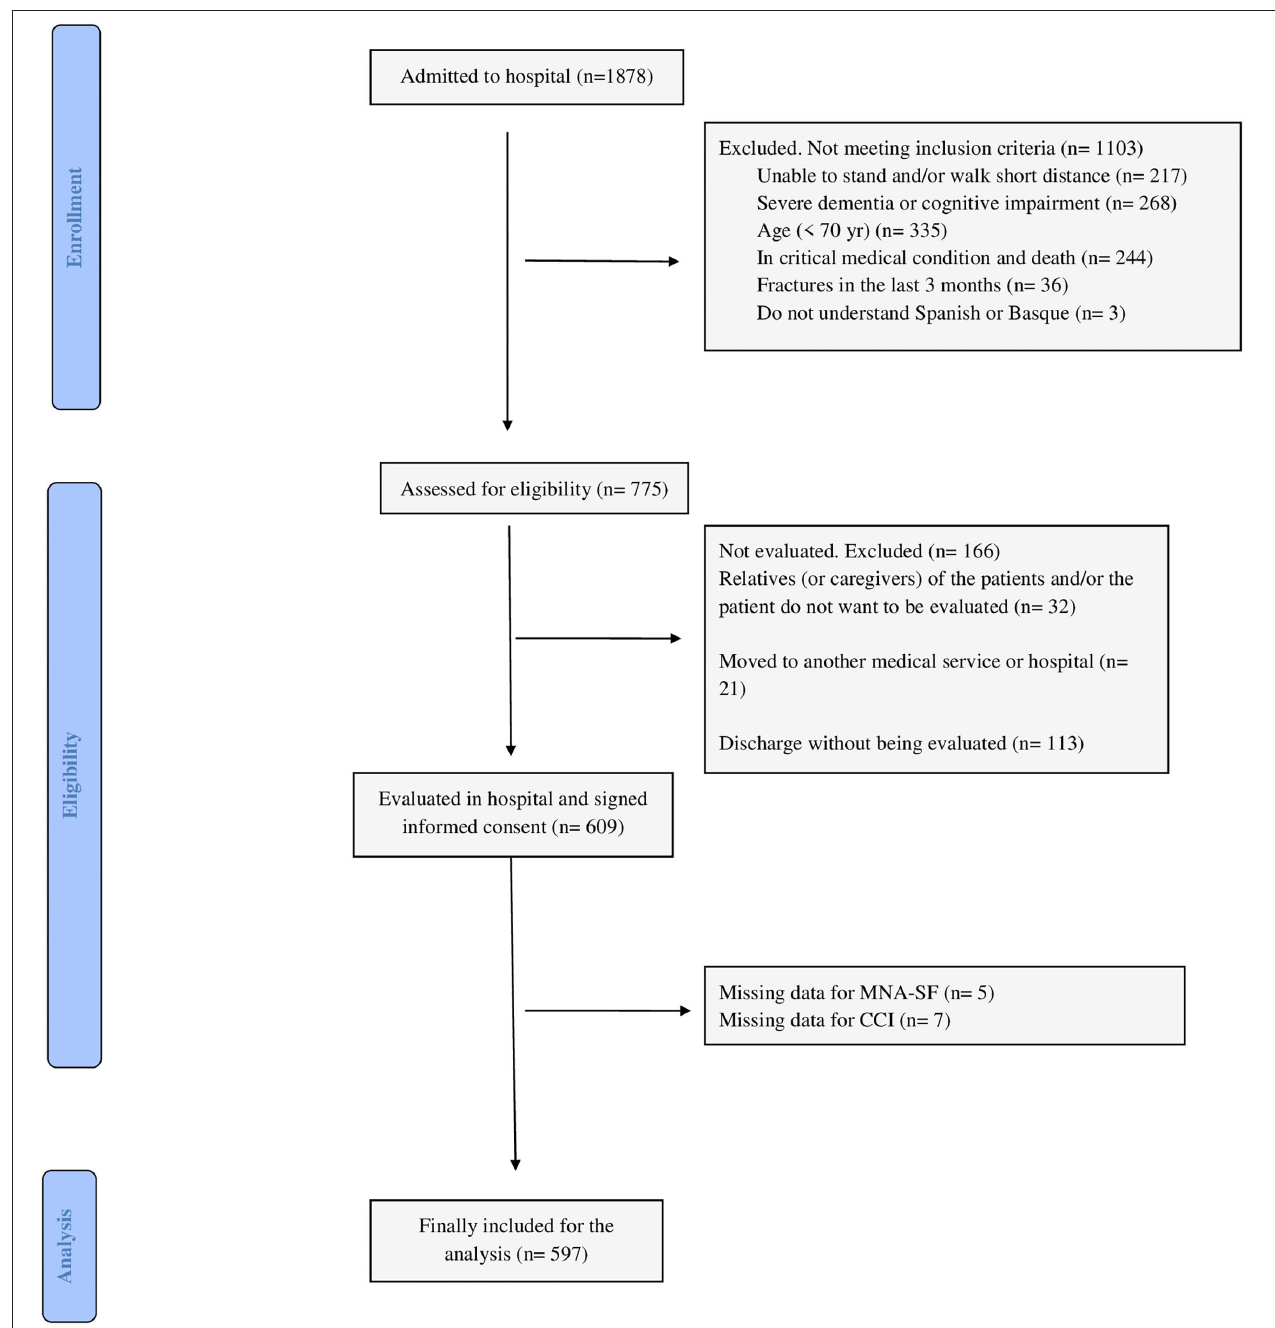
FIGURE 1 | Flow diagram of participants.